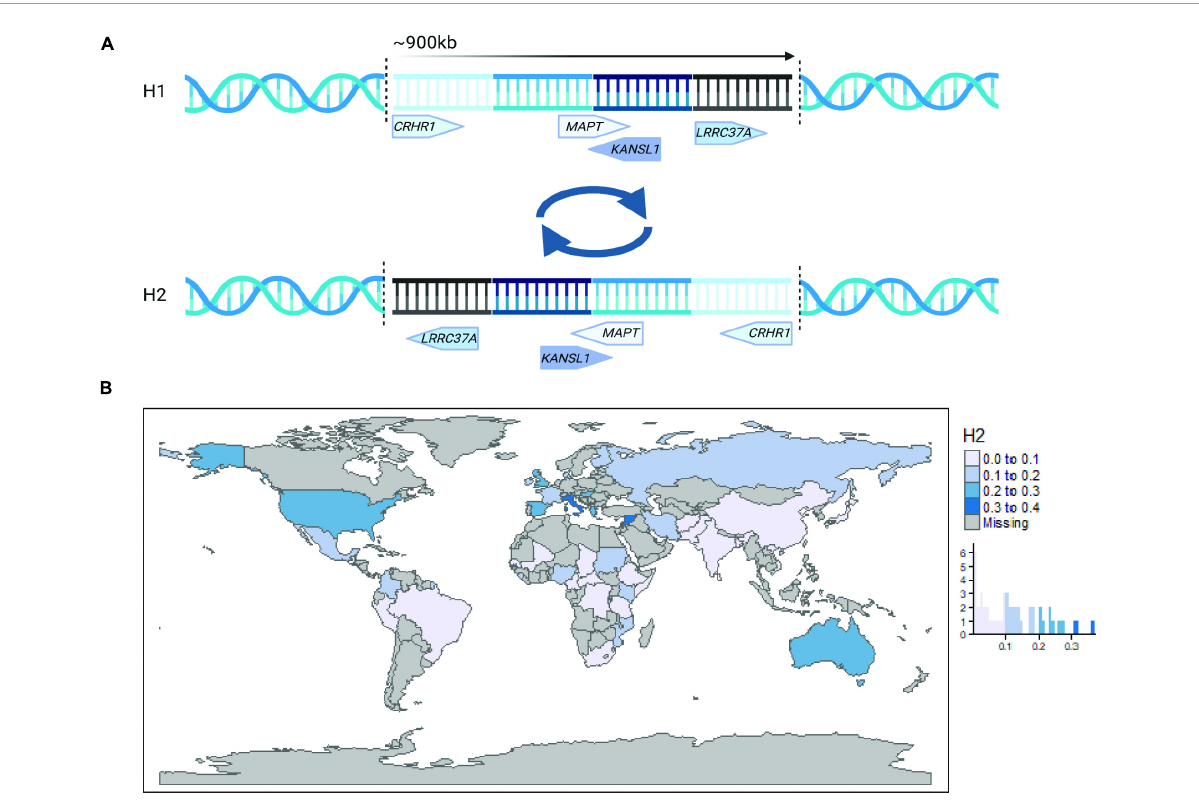
FIGURE1 The 17q21.31 locus. (A) A simplified schematic illustration of the 17q21.31 inversion locus. The inversion breakpoints are represented by vertical dotted lines, and the approximate location and direction of four representative genes are presented for haplotype H1 (top) and H2 (bottom). (B) Worldwide 17q21.31 H2 allele frequency plotted by country and histogram. Haplotype frequency estimates were obtained from Donnelly et al. (2010), Steinberg et al. (2012), and publicly available 1000 Genomes Project data